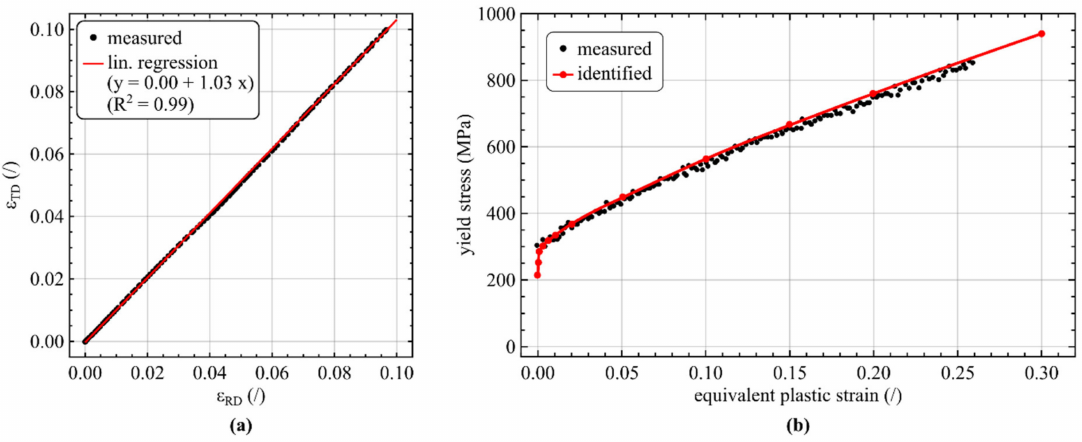
Figure 8. Bulge test results: ( a ) transverse direction strain ε TD as a function of rolling direction strain ε RD , ( b ) yield curve as a function of equivalent plastic strain calculated from the bulge